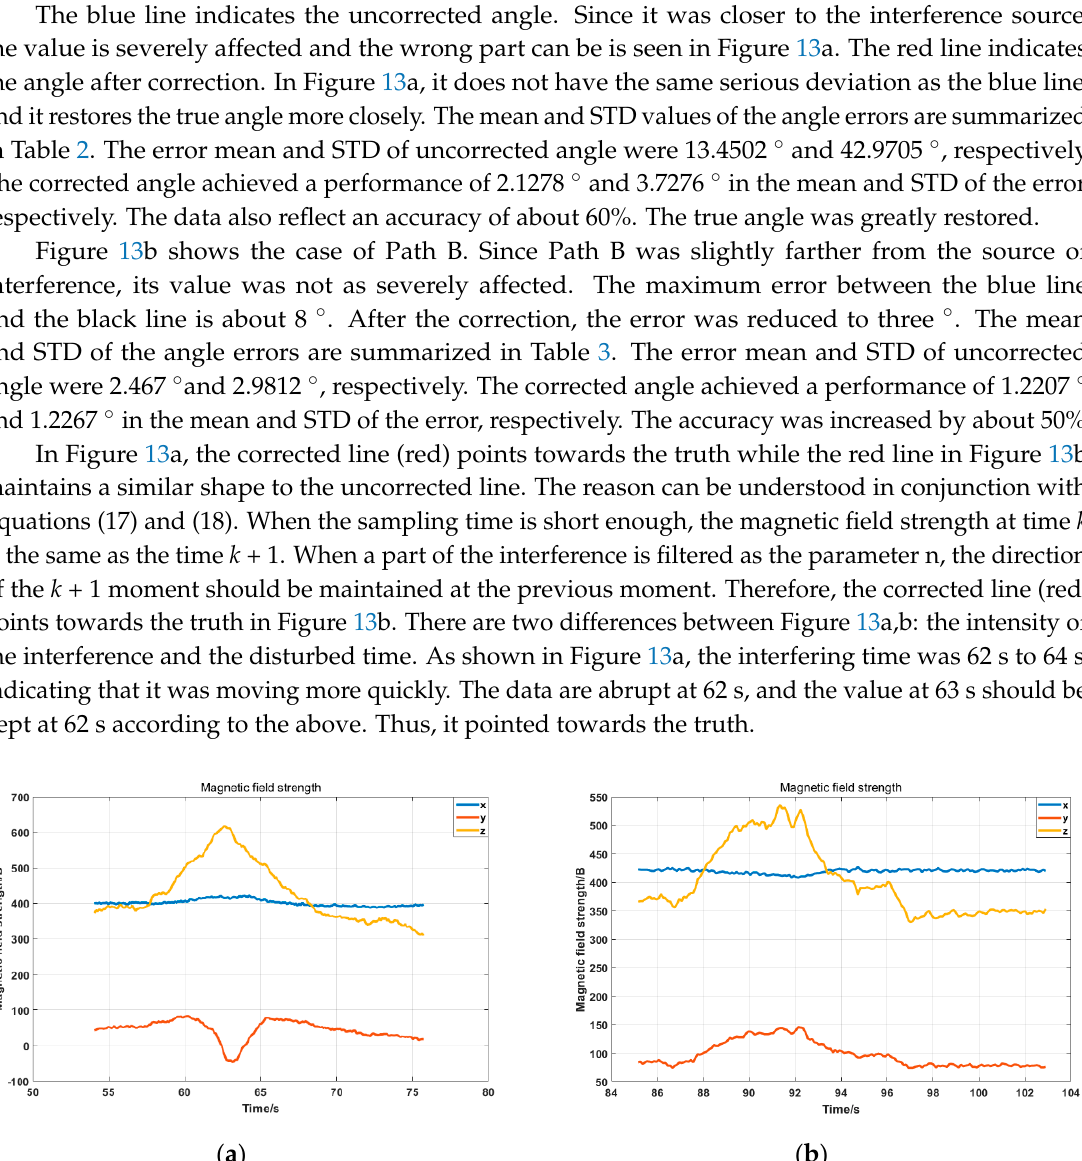
( b ) Figure 13. Heading angle results for two paths: ( a ) angle in large interference; and ( b ) angle in small interference. Table 2. Test Occasion 2: Mean and STD of the heading angle error under large interference. Uncorrected